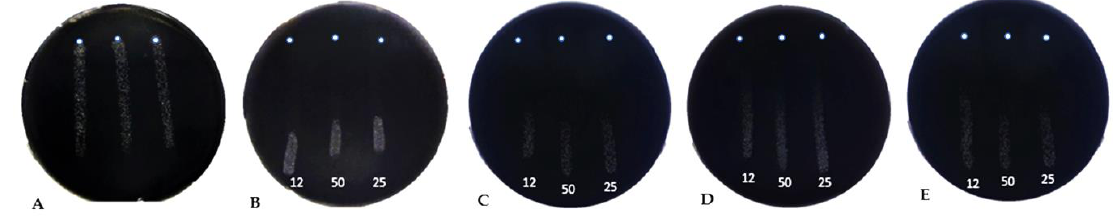
Figure 1. Antibiogram assays of AMPs used against Xylella fastidiosa. ( A ) Untreated Xf used as a negative control; ( B ) GF19-treated Xf ; ( C ) FF13-treated Xf ; ( D ) KL29-treated Xf ; and ( E ) IL14-treated Xf . In petri dishes ( B – E ), AMP drop locations are indicated by white dots at the top of the plate. AMP concentrations ( μM ) are shown at the bottom of the plates.